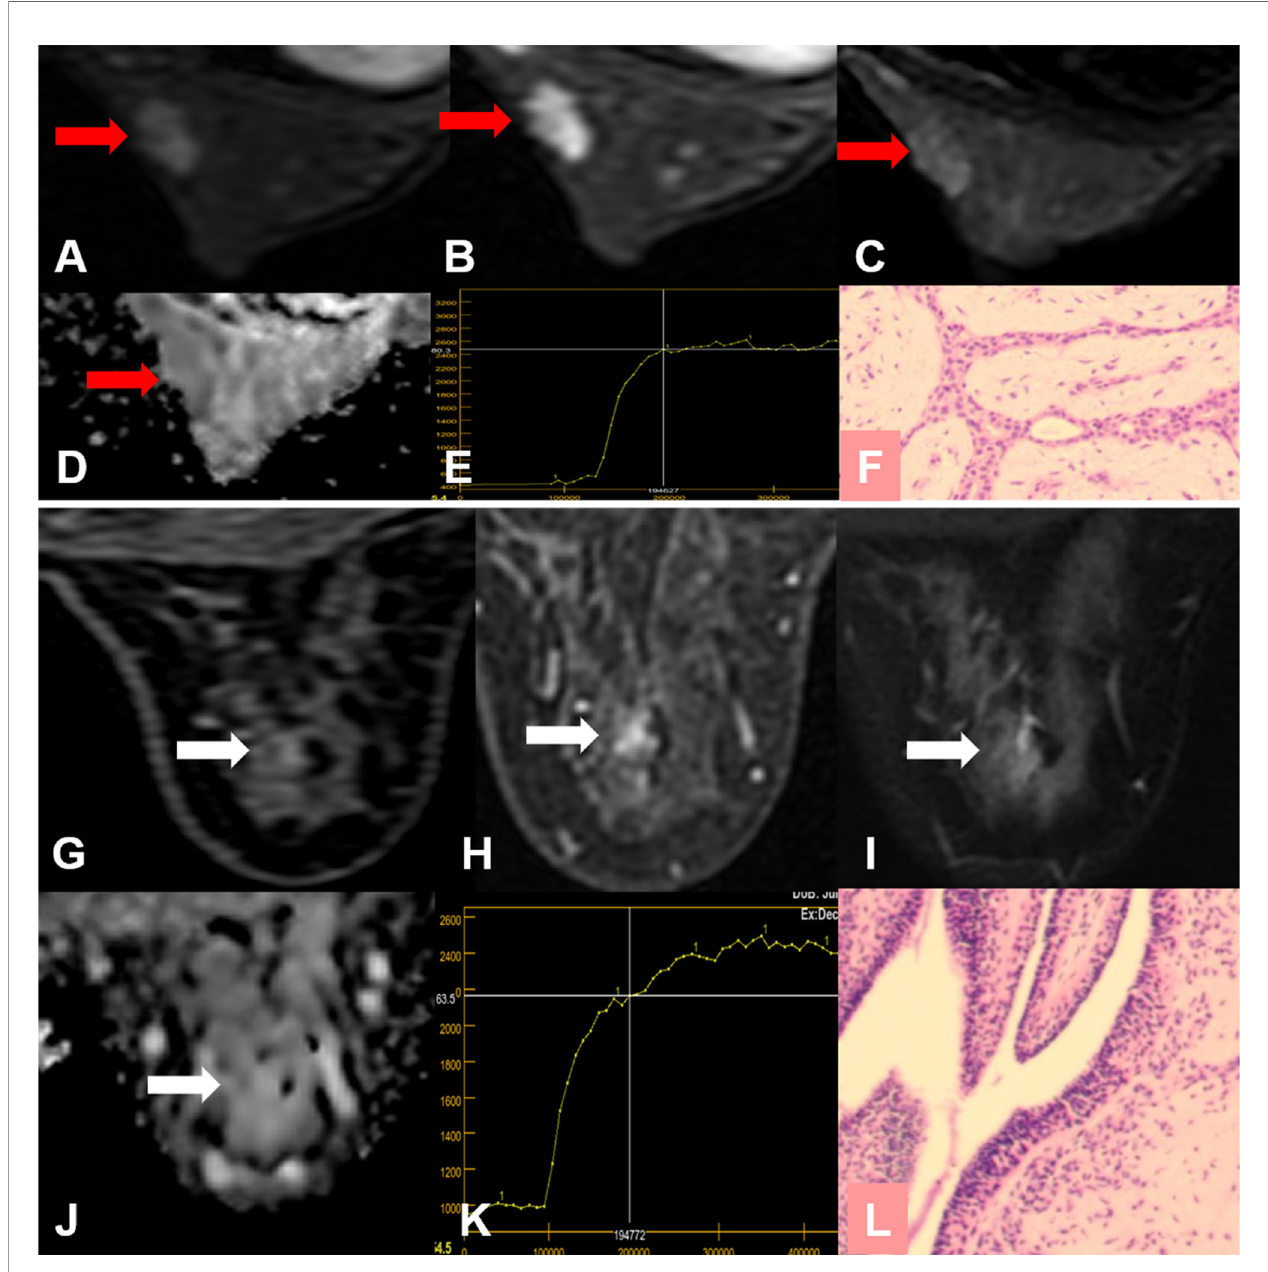
FIGURE 5 | False-positive KS and true-negative KS+ results. (A – F) A 24-year-old female patient: MRI showed a mass lesion in the left breast [ (A – D) , red arrow]. The lesion showed no root sign, a plateau enhancement curve type (E) , and irregular margins (A, B) . (A) Early contrast-enhanced MRI, (B) delayed contrast- enhanced MRI, (C) T2WI with fat suppression, (D) ADC map, (E) TIC curve, (F) pathological image (H&E, 100×). Kaiser score = 5, ADC = 1.69 × 10 − 3 mm 2 /s. Histopathology revealed a fi broadenoma (F) . (G – L) A 53-year-old female patient: MRI showed a non-mass lesion in the right breast [ (G – J) , white arrow]. The lesion showed no root sign, a plateau enhancement curve type (K) and irregular margins (G, H) . (G) Early contrast-enhanced MRI, (H) delayed contrast-enhanced MRI, (I) T2WI with fat suppression, (J) ADC map, (K) TIC curve, (L) pathological image (H&E, 100×). Kaiser score = 5, ADC = 2.12 × 10 − 3 mm 2 /s. Histopathology revealed adenosis (L)